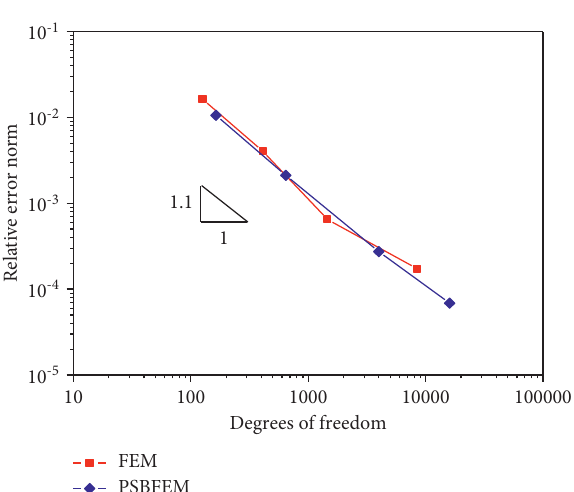
Figure 5: Convergence behavior of the soil foundation in terms of the relative error norm at the first five natural